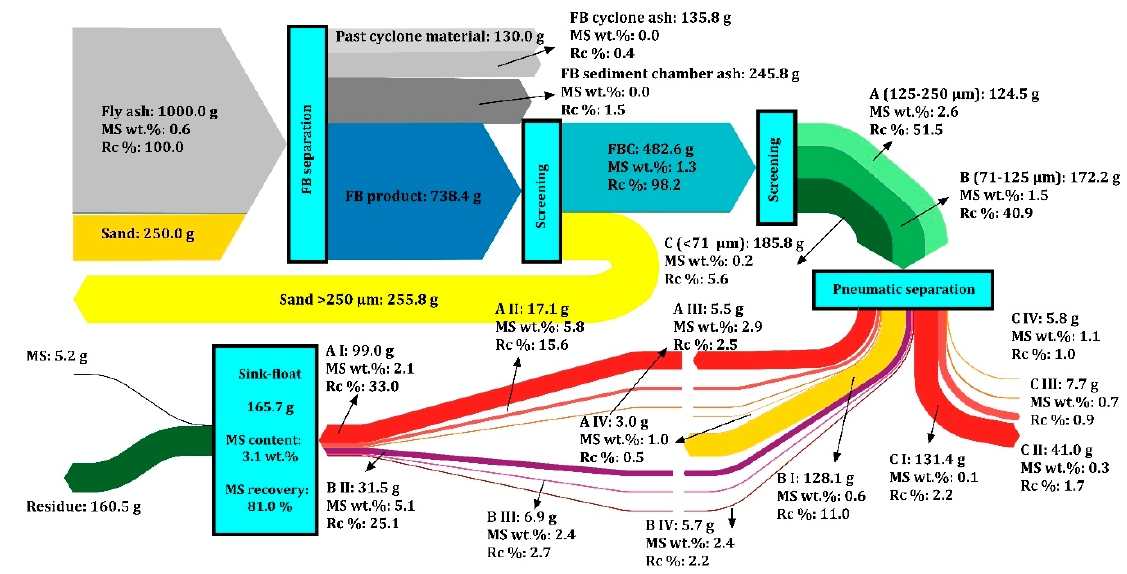
Figure 5. Diagram of the multistage aluminosilicate microspheres recovery from FA 1.